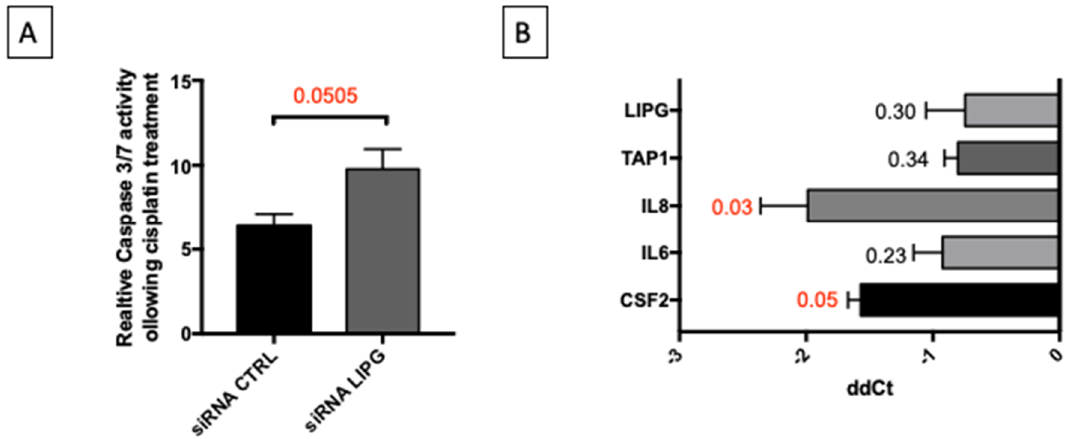
Figure 6. LIPG knockdown sensitizes to cisplatin and oxidative stress induces the expression of genes involved in inflammation. ( A ) PEA1 cells were transfected with control siRNAs or LIPG-directed siRNAs. Twenty-four hours after transfection, cells were treated with 20 µ M cisplatin for additional 48 h. Subsequently, apoptosis was measured by a luminescent caspase 3 / 7 activity assay. Data are expressed as mean ± S.E.M. from four independent experiments with technical triplicates each. The numbers above the bars indicate the statistical significance ( p -value), based on the two-tailed unpaired Student’s t -test. ( B ) Real-time RT-PCR analysis of expression of indicated genes in PEA1 cells treated with 20 µ M H 2 O 2 for 9 h. All data are expressed as mean ± S.E.M. of delta-delta Ct (ddCt) from four independent experiments with technical triplicates each. Numbers indicate the statistical significance ( p -value), based on the Student’s t -test (significant values are highlighted in red).